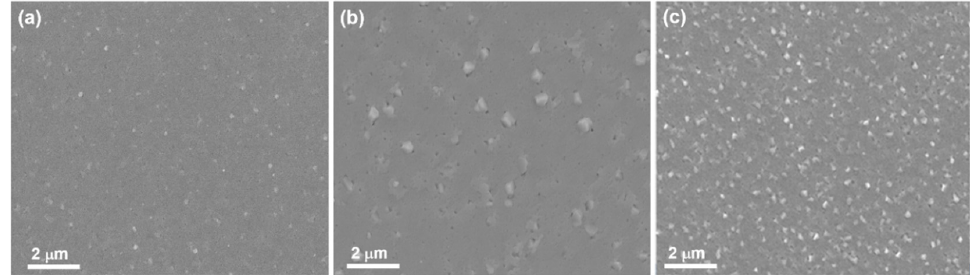
Figure 3. SEM images of Ni 51.0 Mn 27.5 Ga 21.5 thin films. ( a ) 200 nm, ( b ) 400 nm, and ( c ) 600 nm.